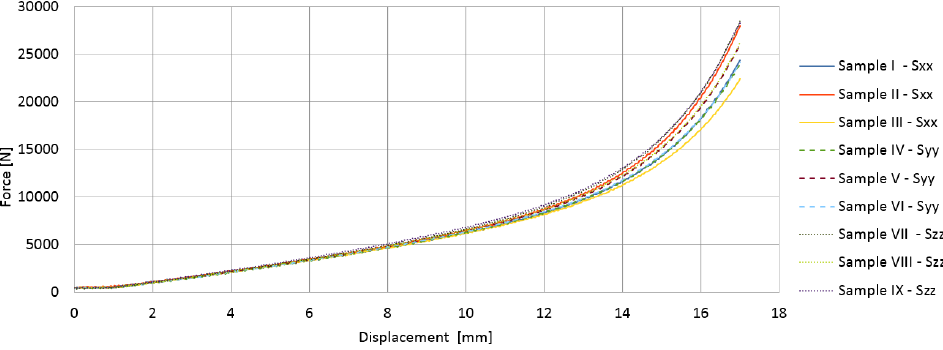
Figure 6. Force vs. displacement for compression tests of VE material in different